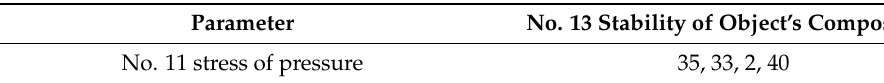
Table 5. Contradiction matrix table of Plan 1.